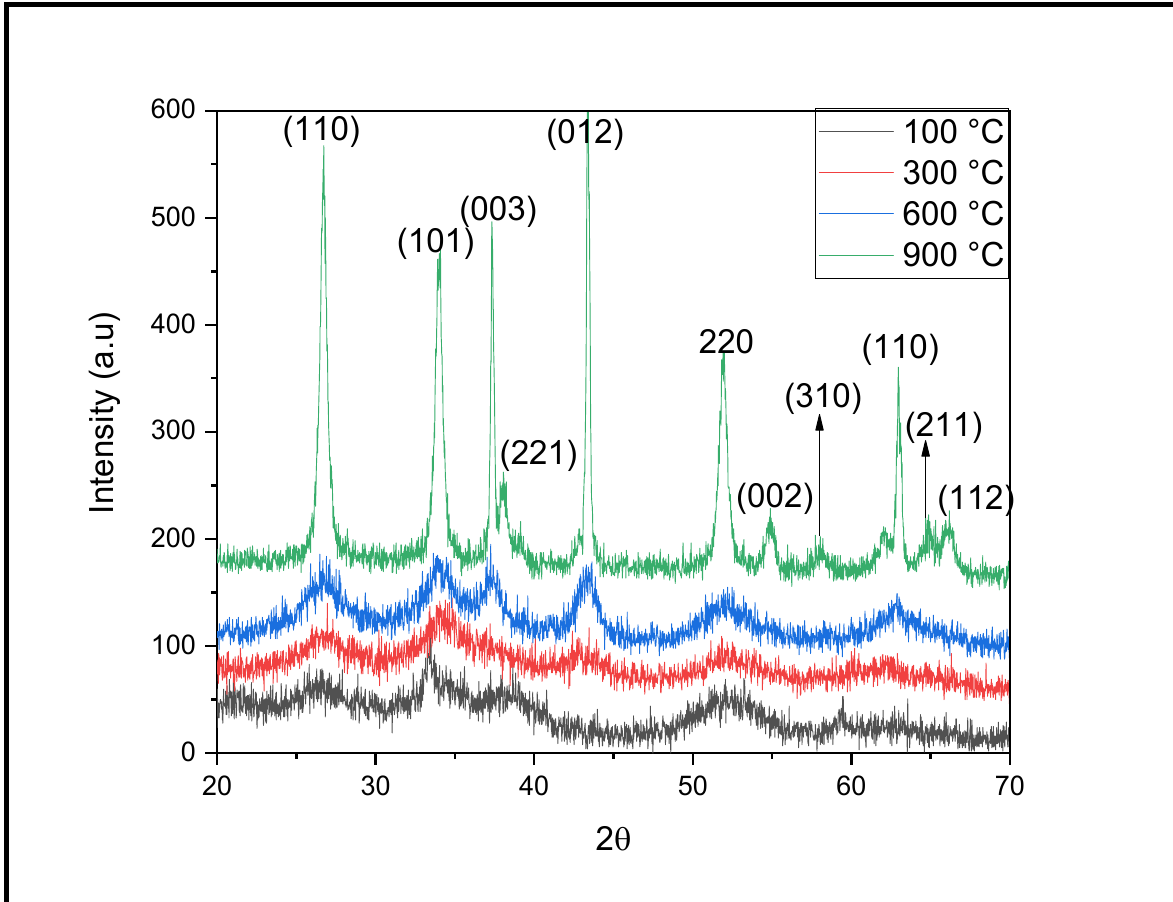
Figure 1. XRD diffractograms of NiO ‐ SnO 2 NCs calcined at the indicated temperature.